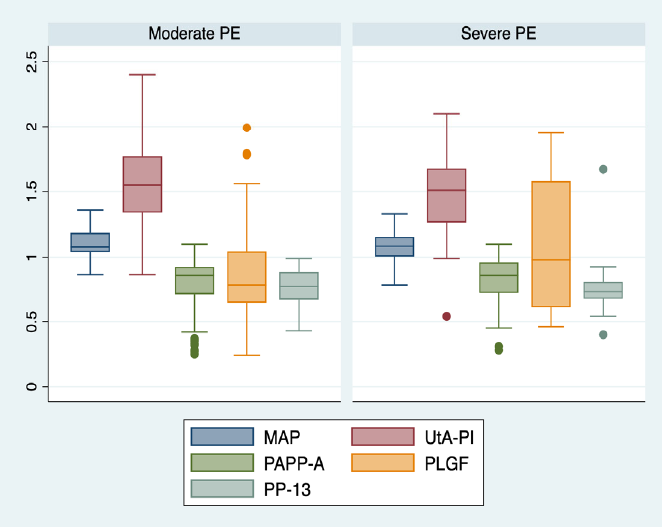
Figure 2. Boxplot representing the comparison of paraclinical parameters in subgroups 3 and 4. Legend: MAP—mean arterial pressure; UtA ‐ PI—uterine artery pulsatility index; PLGF—placental growth factor; PP ‐ 13—placental protein ‐ 13; PAPP ‐ A—pregnancy ‐ associated plasma protein ‐ A;